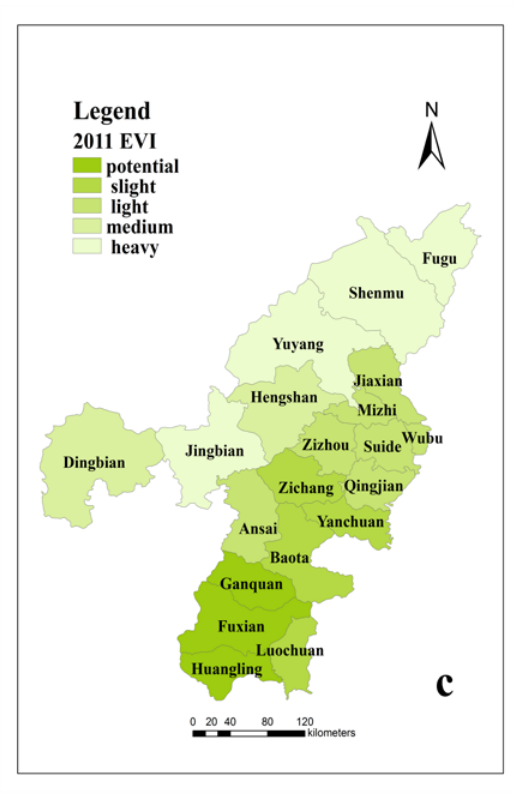
Figure 3. The ecological vulnerability of Northern Shaanxi in 1997 ( a ), 2004 ( b ) and 2011 ( c